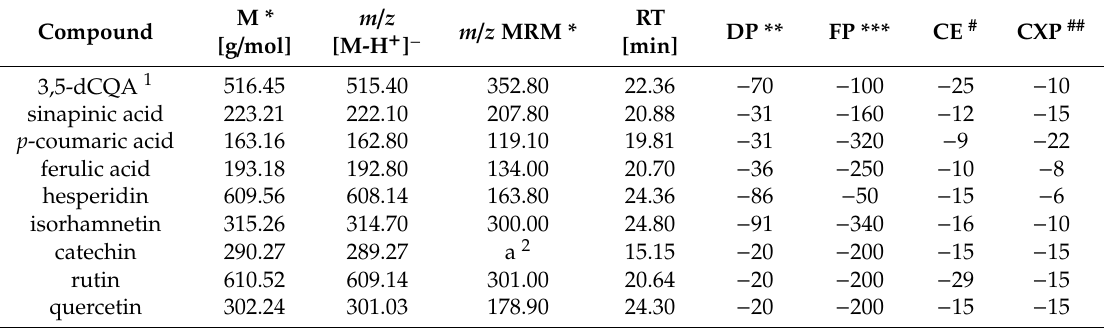
Table 1. The ion path parameters obtained following individual compounds optimization.